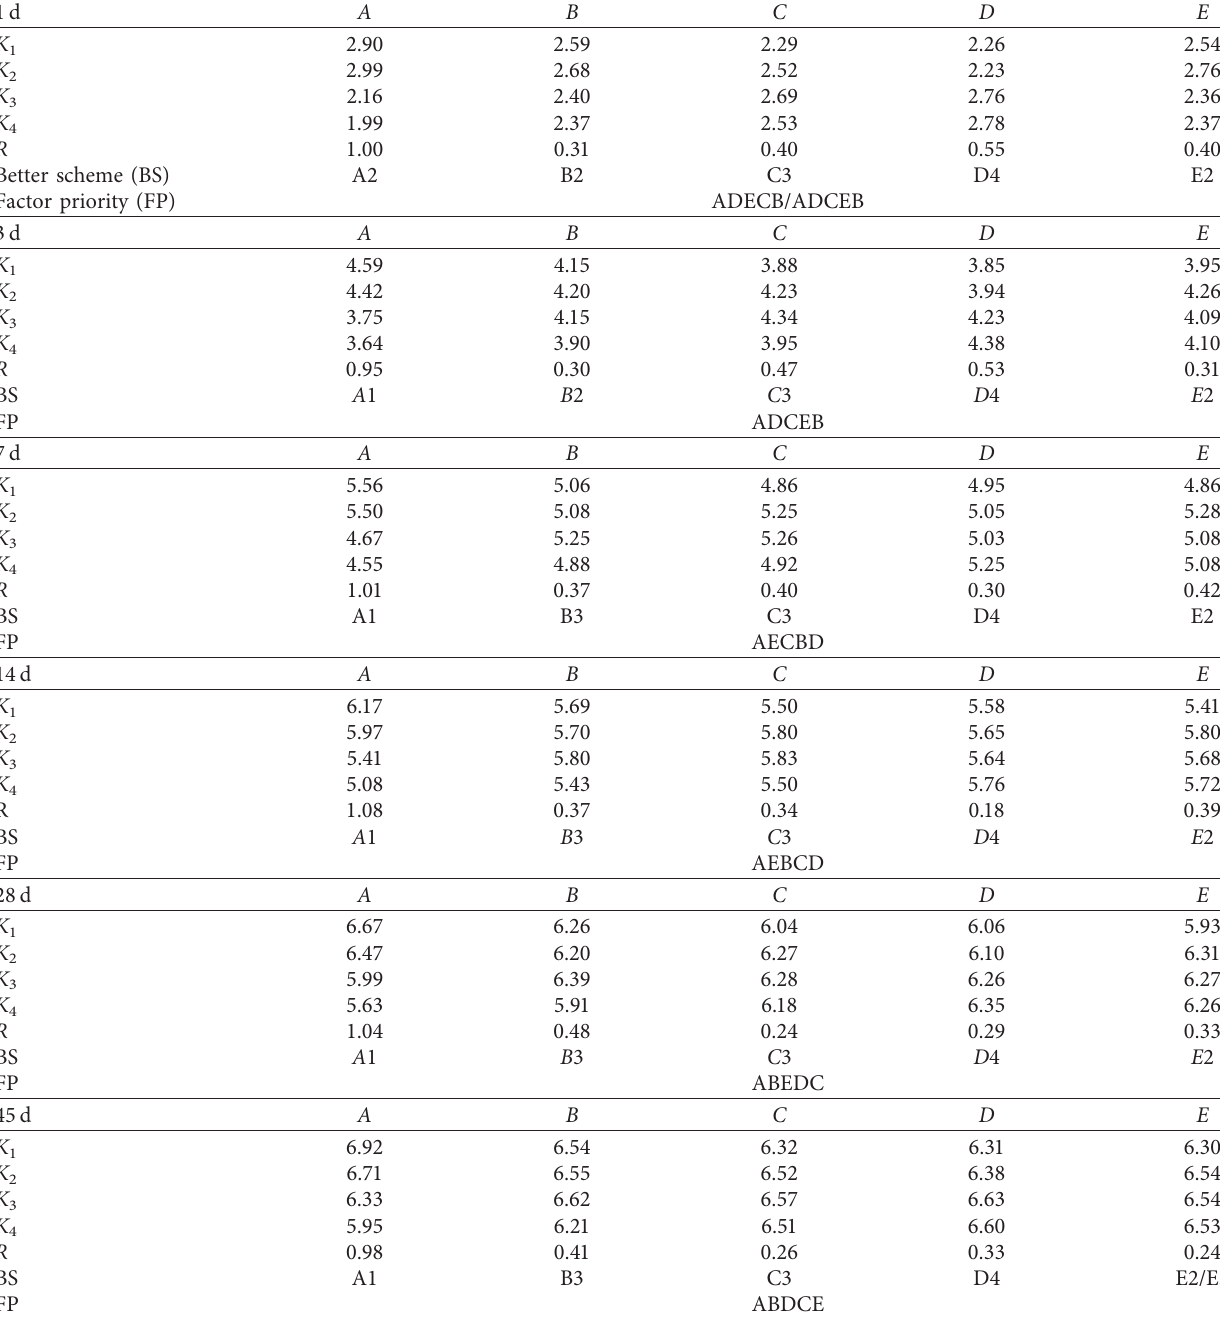
Table 5: Range analysis of concrete flexural